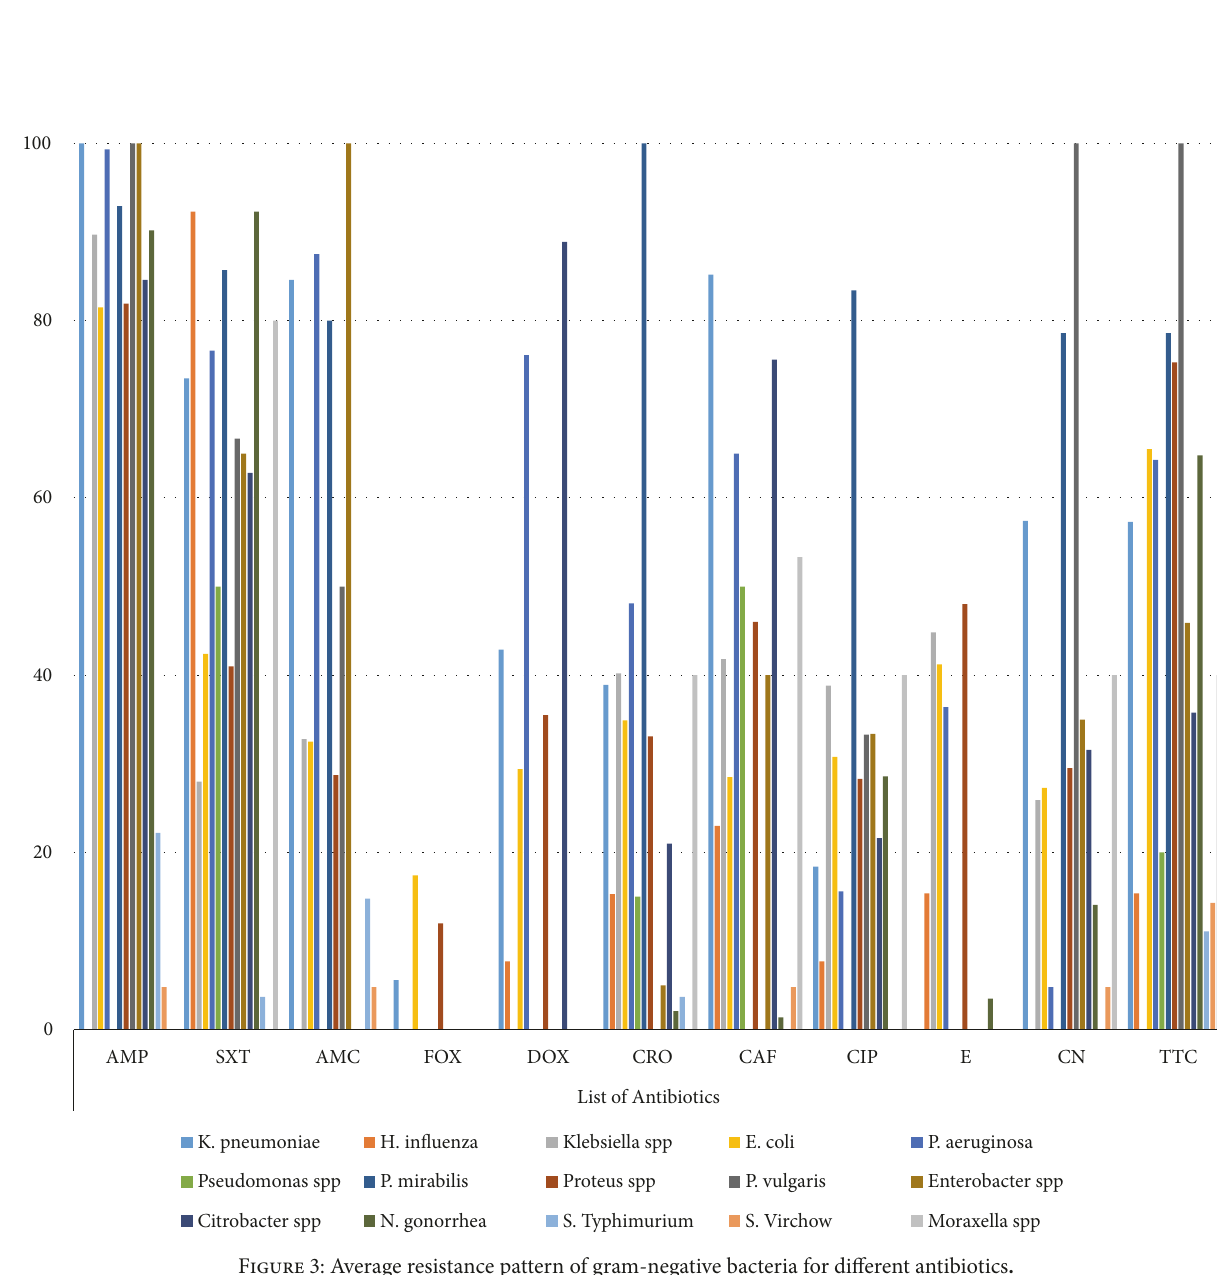
and their resistance pattern for around 12 antibiotics. It covers most of the regions which are found in Ethiopia. The resistance pattern of the isolates ranged from 0% up to 100%. Fifteen gram-negative bacteria were recovered from various specimens. Like the gram-positive bacteria, the resistance pattern ranges from 0% up to 100%. Almost all bacterial isolates were highly resistant for ampicillin. Relatively, isolates